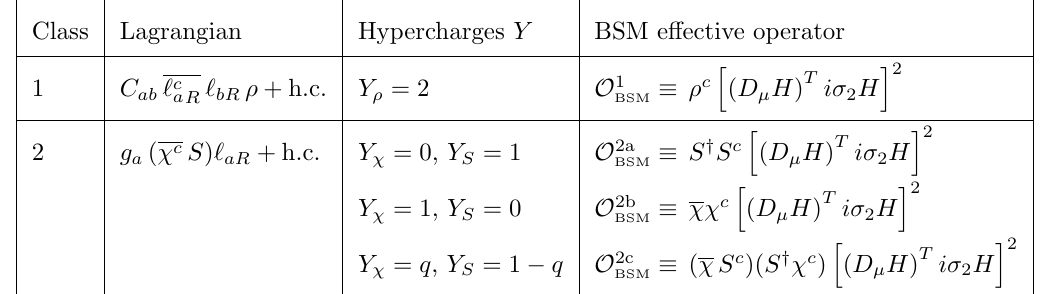
Table 1 . UV completions of the lepton number breaking operator in two categories ( Class 1 and 2) determined by the type of renormalizable BSM interactions with right-handed SM leptons (Lagrangian). Depending on the hypercharge assignments ( Y ) of the participating BSM (cid:12)elds, the interactions in Class 2 have three di(cid:11)erent lowest-order BSM e(cid:11)ective 2a,2b,2c operators ( O